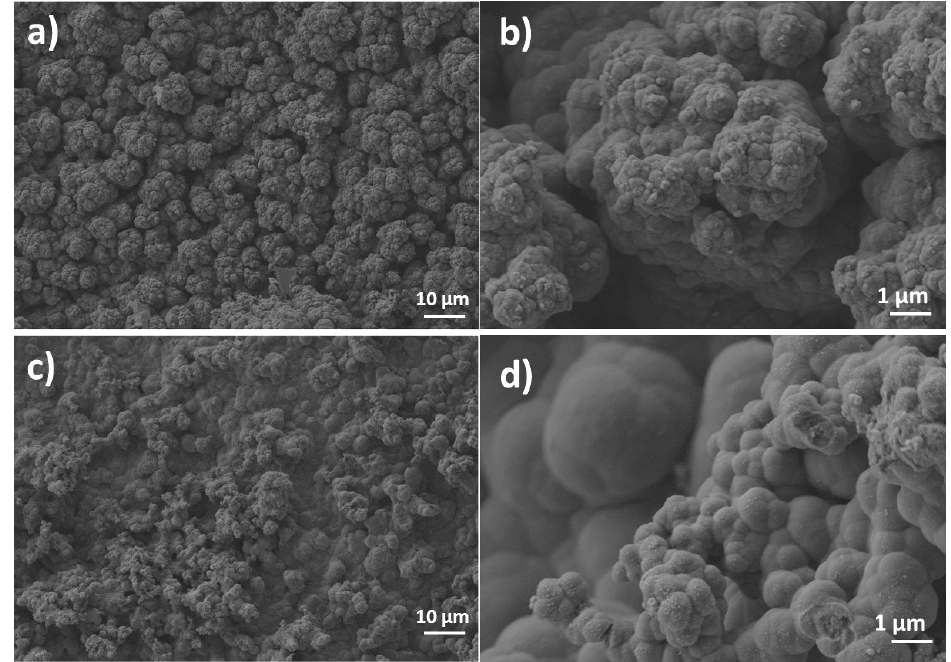
Figure 5. FE-SEM images of the deposition of PPy onto CS electrodes modified with electroreduced GO (rGO E) ( a,b ) and chemically-reduced GO (rGO C ) ( c,d ).